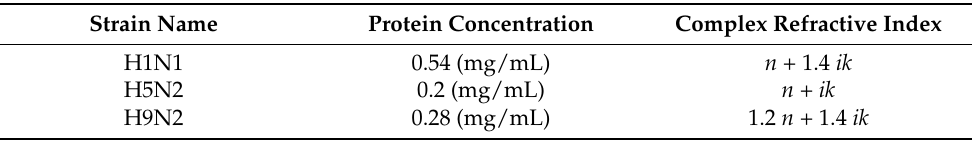
Table 2. Synthetic summery of THz technology characteristics. Advantages and disadvantages as a detection